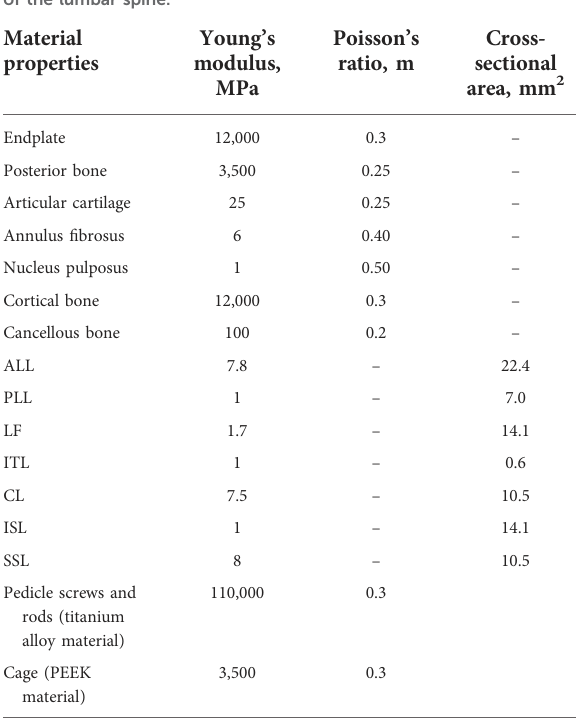
TABLE 1 Material properties used in the present fi nite-element model of the lumbar